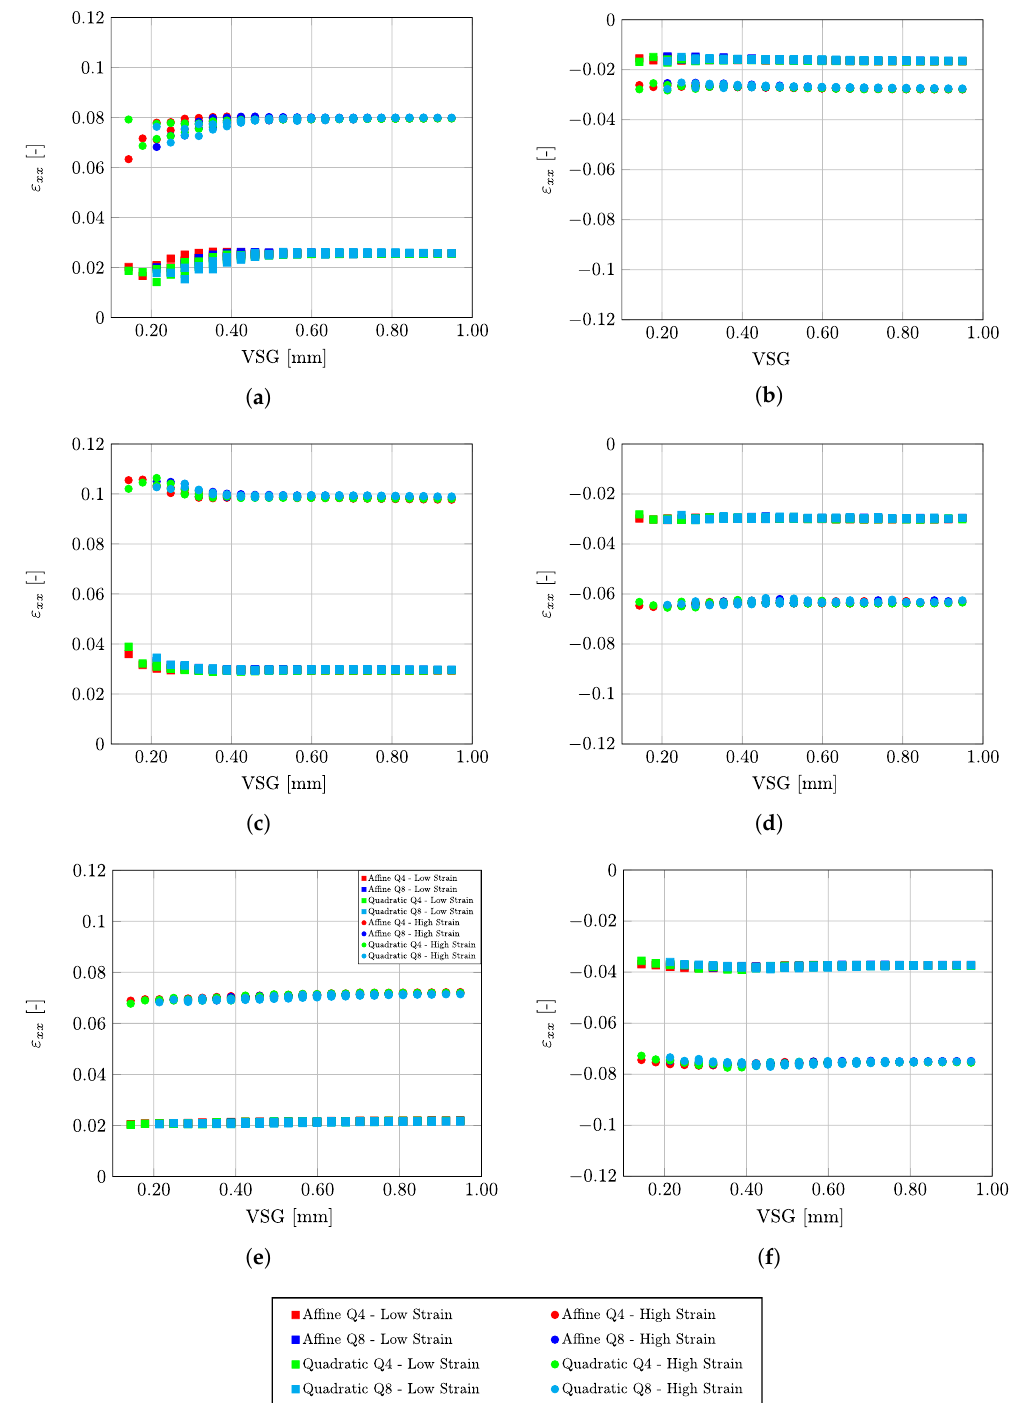
Figure 4. Evaluation of ε xx for points A, B, and C (Figure 3) as a function of DIC parameters expressed with regard to Virtual Strain Gauge (VSG) for both tension and compression tests, at two stages of deformation corresponding low and high strains. ( a ) Point A—Tension; ( b ) Point A—Compression; ( c ) Point B—Tension; ( d ) Point B—Compression; ( e ) Point C—Tension; ( f ) Point